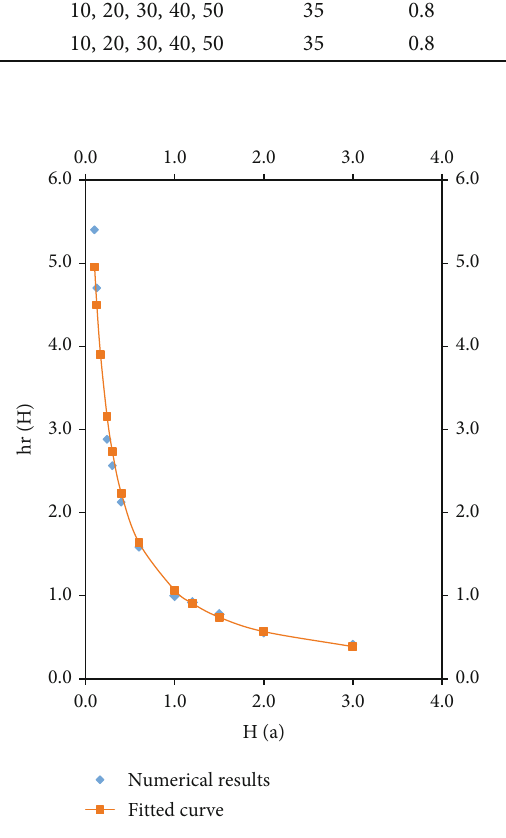
Figure 4: The relationship between ratio of unloading in fl uence depth to excavation depth ( hr / H ) and the excavation depth width ratio ( H / a